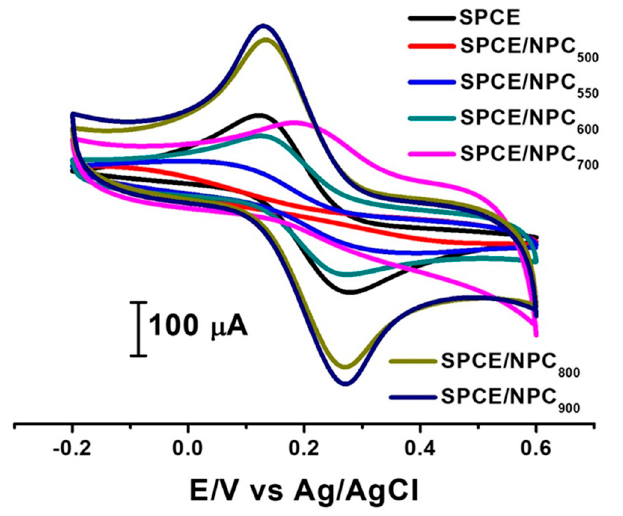
Figure 5. Cyclic voltammetric response of SPCE and SPCE/NPC T in 5 mM ferric cyanide